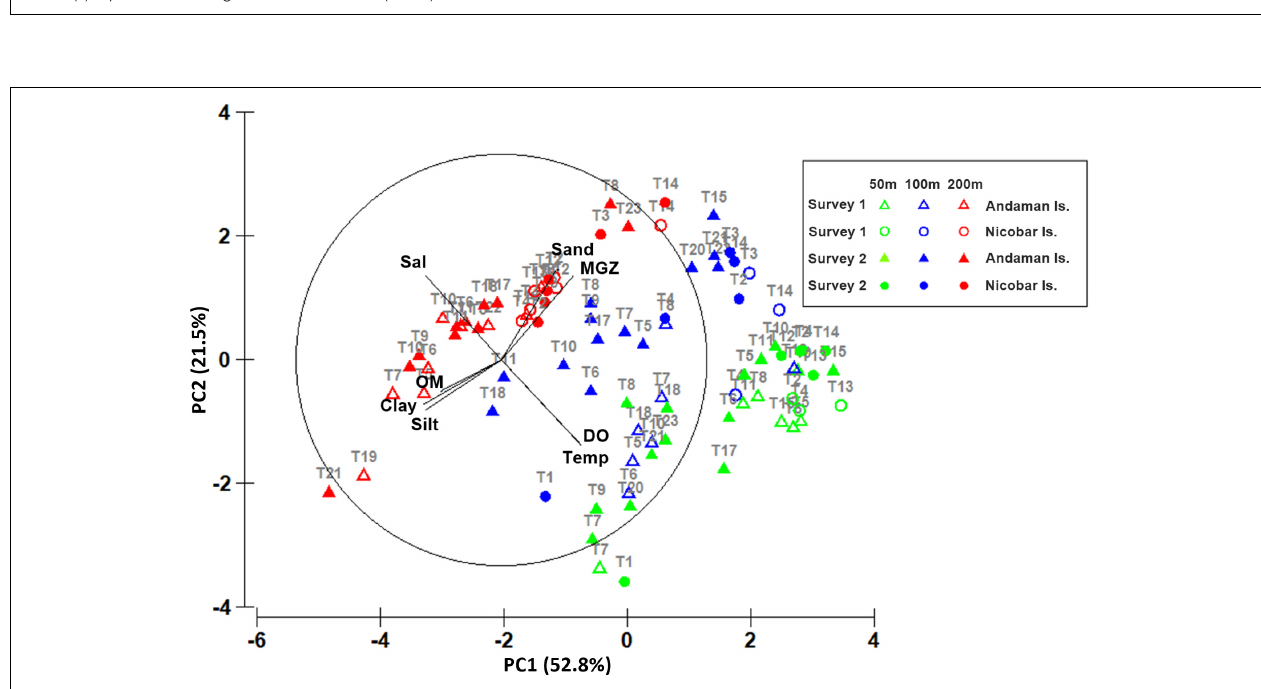
FIGURE 4 | Principal Component Analysis (PCA) showing ordination of sites with respect to spatial variations in environmental factors (arrows: Temp-Temperature, Sal-Salinity, DO-Dissolved oxygen, Sand, Silt, Clay, MGZ-Median grain size, OM-Organic matter) at 50 m (green), 100 m (blue) and 200 m (red) depth strata around Andaman Islands ( (cid:78) ) and Nicobar Islands ( • ) in survey 1 (hollow symbols) and survey 2 (filled symbols).